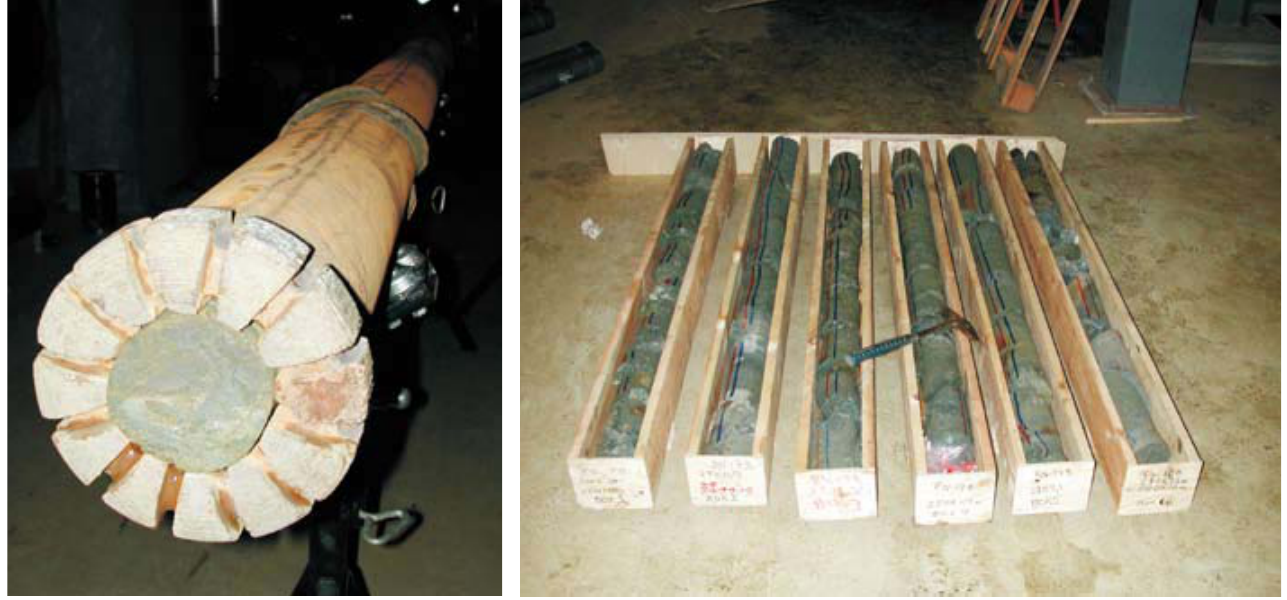
Figure 8. Cores boxed for examination.Figure 7. Core bit with core securely held in